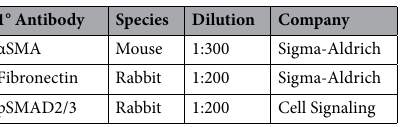
Table 3. List of indirect immunofluorescence primary